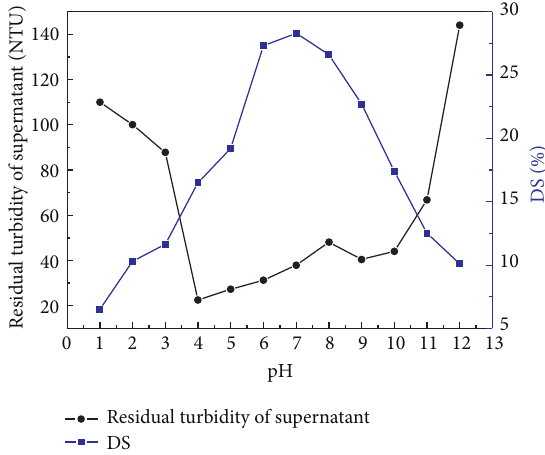
Figure 4: Effect of pH on sludge dewatering